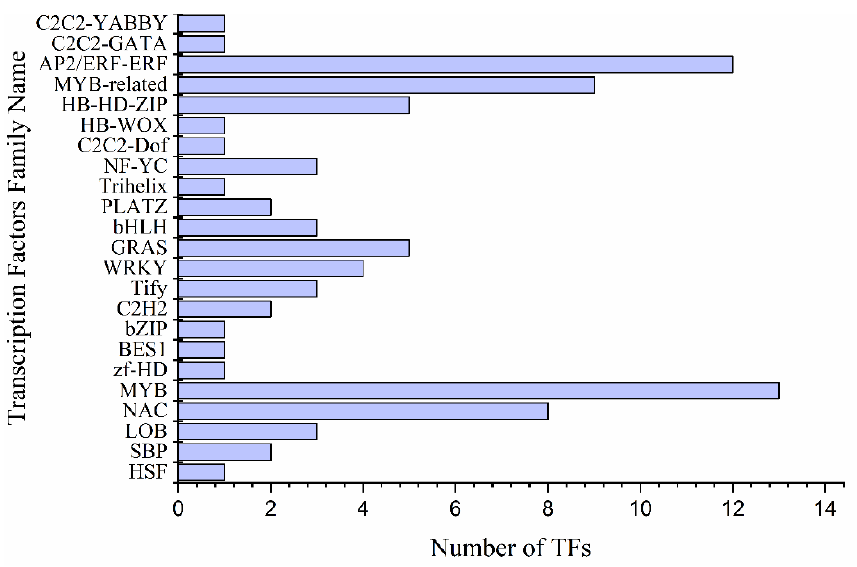
Figure 5. Differentially expressed transcription factors family under drought stress.